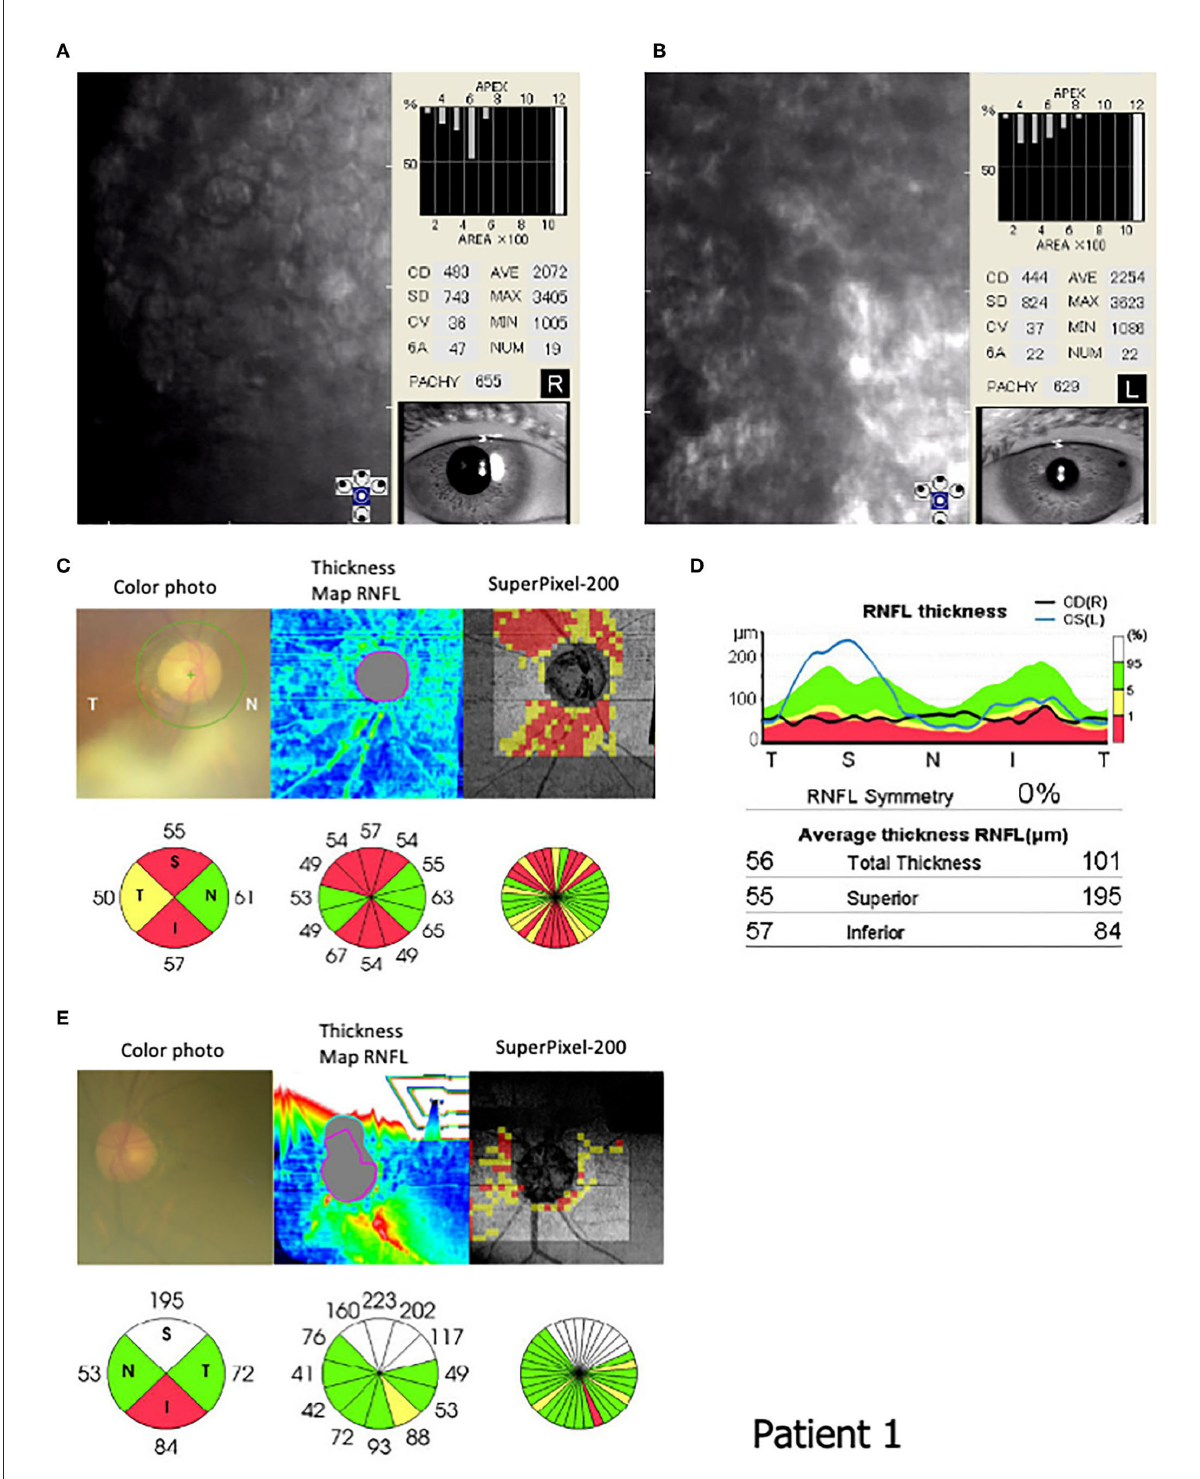
FIGURE3 Endothelial corneal cell density (ECD) and circumpapillary retinal nerve fiber layer (RNFL) in Patient 1 (III-10). Specular microscopy (FA-3609, Konan Medical, Inc. Japan) shows (B) corneal guttata, (A,B) pleomorphic cellular patterns of endothelial structures, and (B) rounded dark cells with light borders. The corneal cell density is 483 and 444 cells/mm 2 in the (A) right and (B) left eyes, respectively. (C–E) An optical coherence tomography (OCT: 3D CT-2000, Topcon Medical Japan, Co. Ltd, Japan) indicates the ocular fundus color photograph, RNFL thickness map, super Pixel-200 image, and RNFL values in the circular areas. An OCT shows RNFL thinning in the superior (55 µ m) and inferior (57 µ m) areas of the (C) right eye and inferior area (84 µ m) of the (E) left